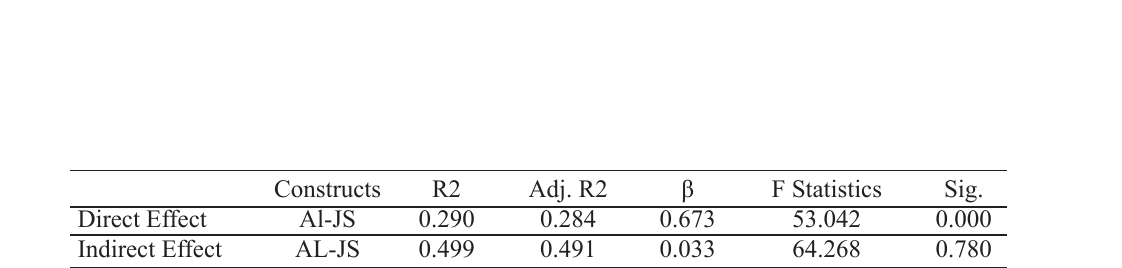
Table-4: Summary of